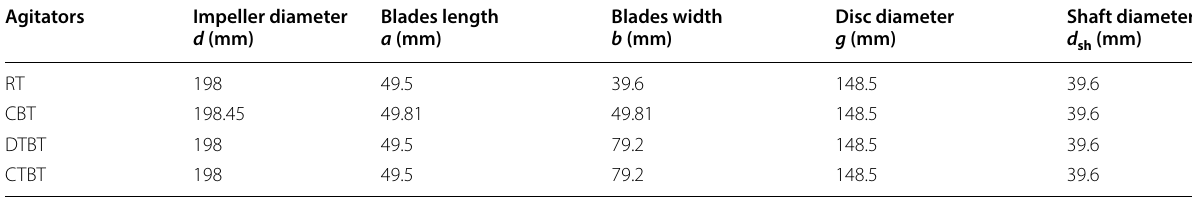
Table 1 Impellers geometrical proprieties